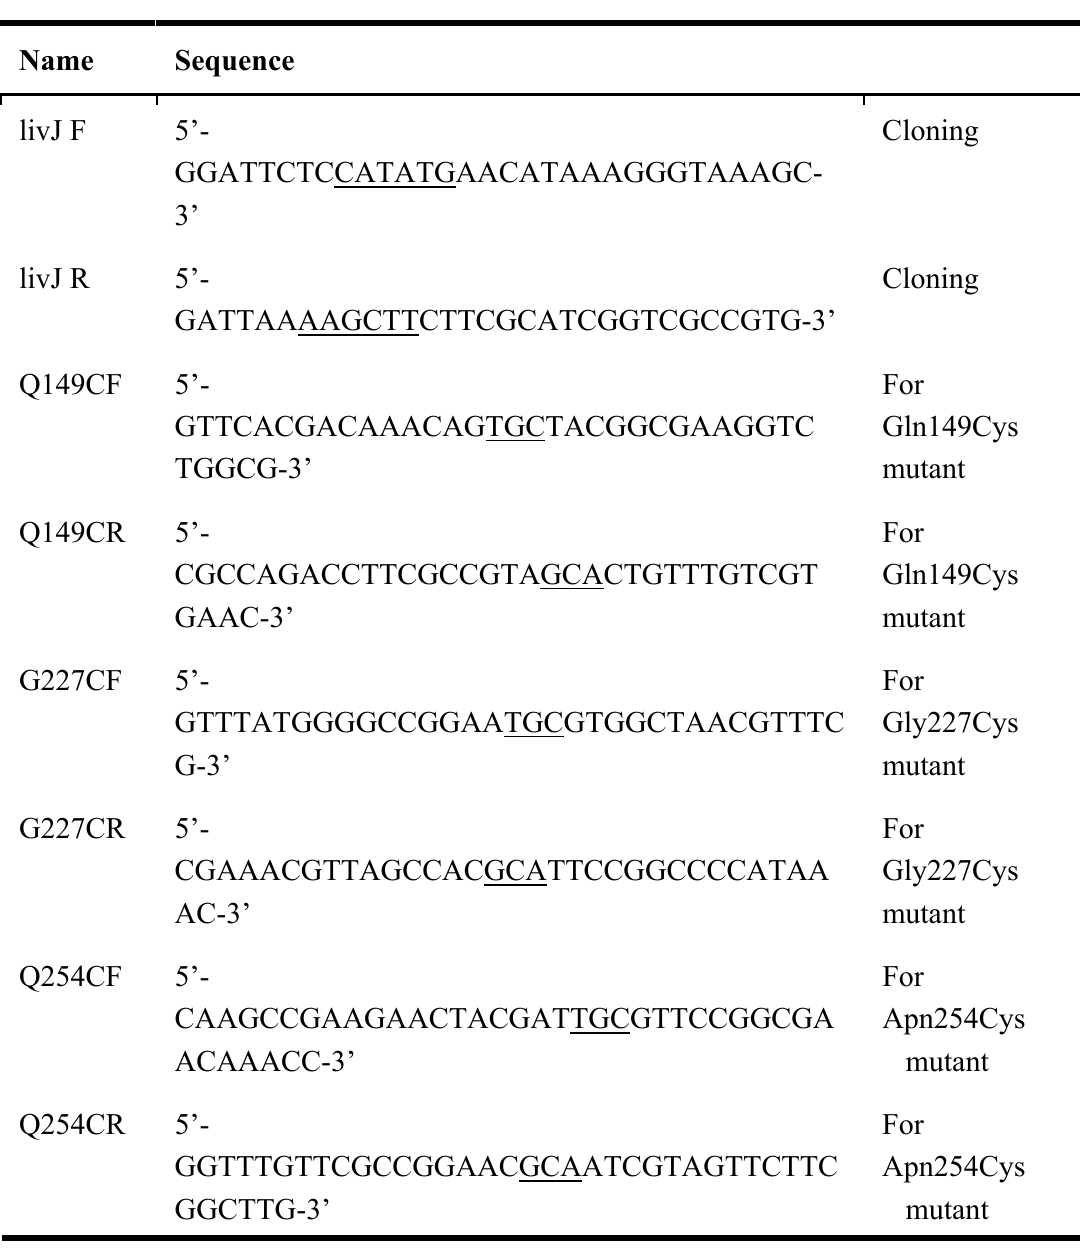
Table 1. Primers used for cloning and mutagenesis of